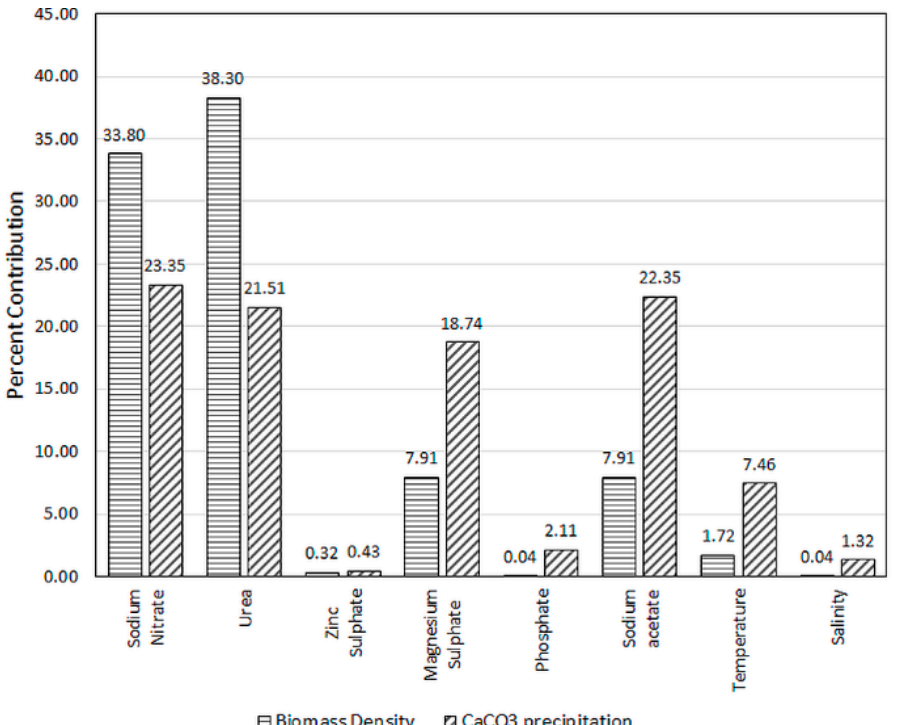
Figure2. PercentcontributionofdifferentfactorsonbiomassdensityandCaCO 3 Figure 2. Percent contribution of different factors on biomass density and CaCO 3 precipitates concentration.